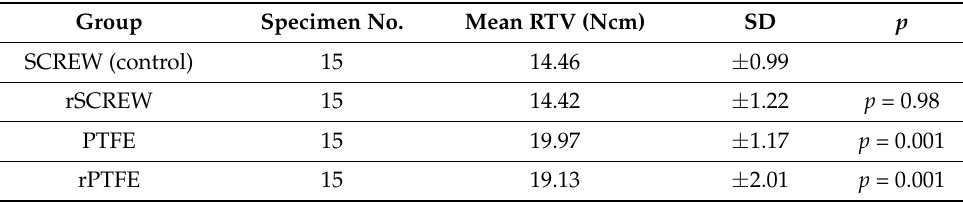
Table 1. Mean RTV, standard deviation (SD), and statistical significance ( p ) between SCREW (control) and experimental groups. Group Specimen